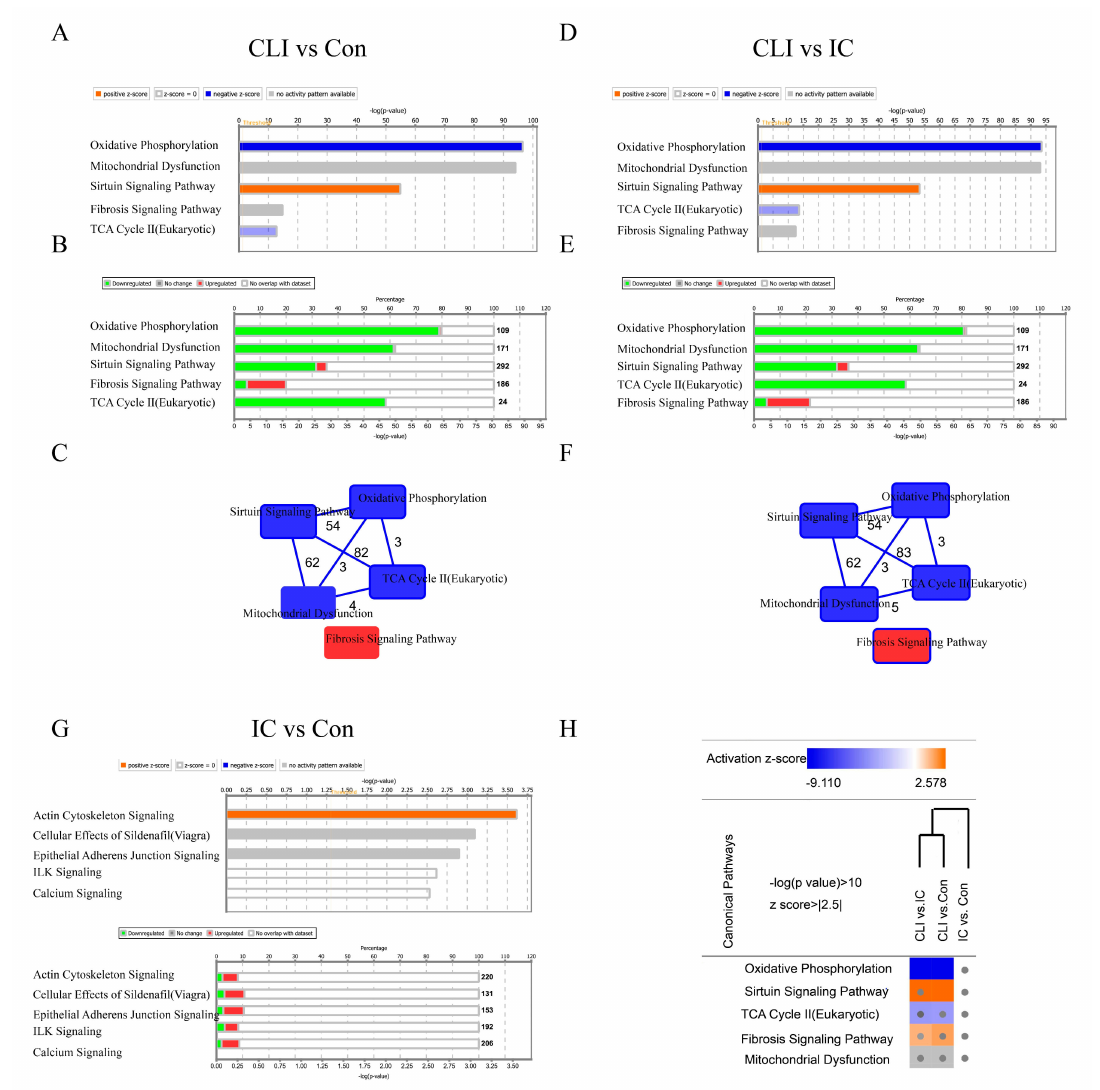
Figure 3. IPA of genes di ff erentially expressed between CLI and IC and Con. Di ff erentially expressed genes calculated using DeSeq2 (FC > 2, FDR < 0.05) were merged and submitted for IPA analysis. ( A , D ) A selection of highly significant functions and their activation z-scores are shown in the bar graphs (orange for positive Z score, blue for negative Z score, and gray for no activation pattern available). The x-axis corresponds to the –log of the p -value (Fisher’s exact test); ( B , E ) a selection of highly significant functions and their activation percentage are shown in the stack bar graphs (red for activation, green for inhibition. Number for each bar for the total molecular in this pathway.) ( C , F ) Overlaying pathways. ( C ) CLI vs. Con; ( F ) CLI vs. IC; ( A – C ) for CLI vs. Con; ( D – F ) for CLI vs. IC. ( G ) Bar and stacked bar graph of first five function and their activation when IC vs. Con. ( H ) Canonical pathway heatmap of three comparisons. 3.4 Fibrosis pathways are enriched in CLI patients compared to IC and controls. TCA, Tricarboxylic Acid Cycle; FC, Fold Change; ILK, Integrin Linked Kinase; IPA, Ingenuity Pathway